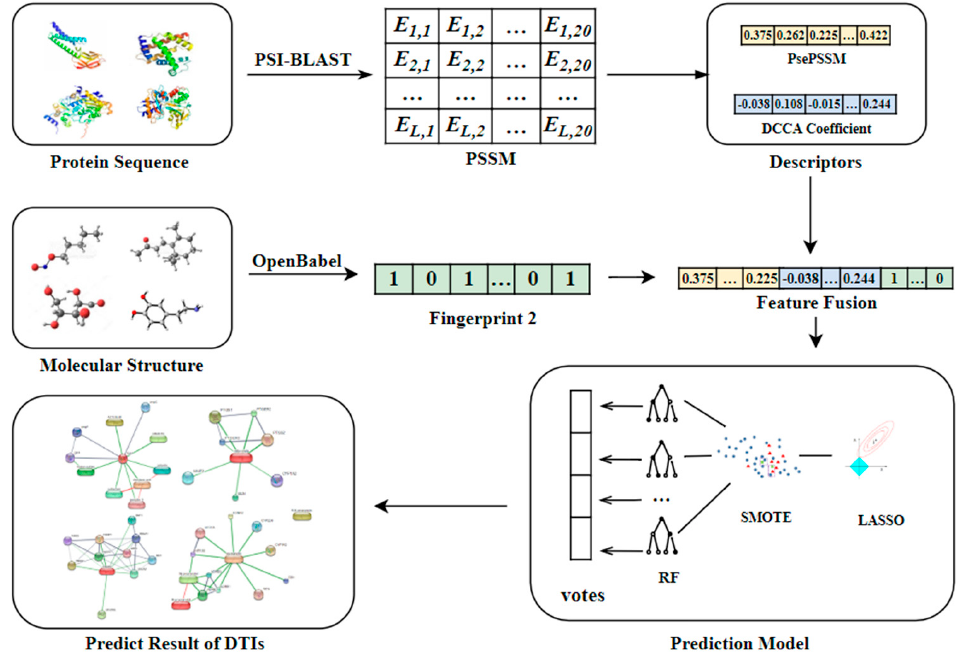
Figure 1. The workflow of PsePDC-DTIs.